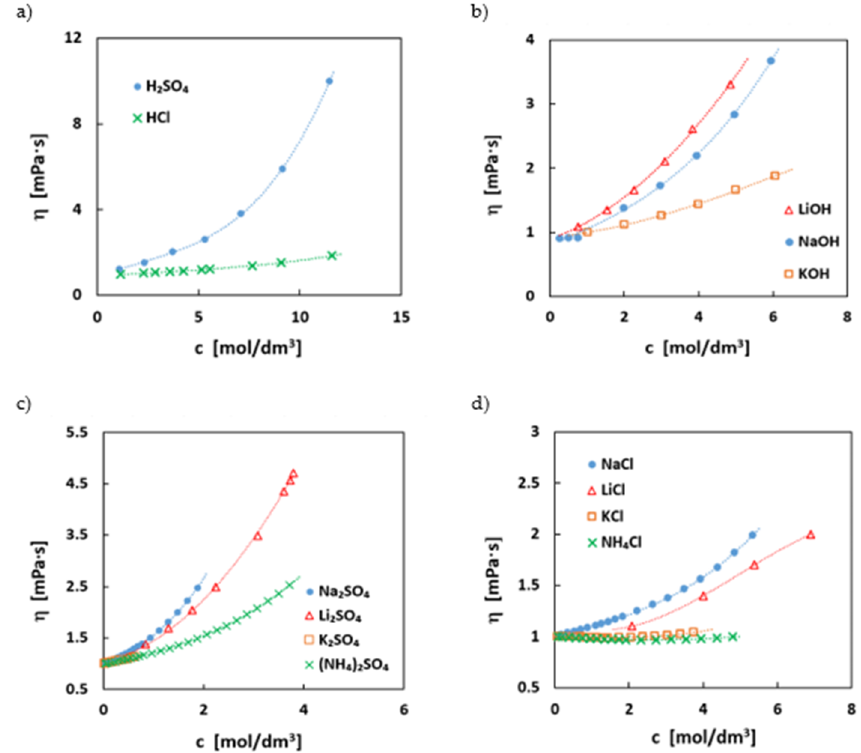
Figure 4. Variation of the viscosity ( η ) with the concentration (c) for some electrolyte solutions used in RFB at 298.15 K: ( a ) sulfuric acid ( • ) [49] and hydrochloride (x) [50]; ( b ) sodium hydroxide ( • ) [51]: potassium hydroxide ( (cid:3) ) [51] and lithium hydroxide ( ∆ ) [51]; ( c ) sodium sulfate ( • ) [46], potassium sulfate ( (cid:3) ) [46], lithium sulfate ( ∆ ) [47], and ammonium sulfate (x) [46]; ( d ) sodium chloride ( • ) [46], potassium chloride ( (cid:3) ) [46]; lithium chloride ( ∆ ) [52], and ammonium chloride (x) [46].